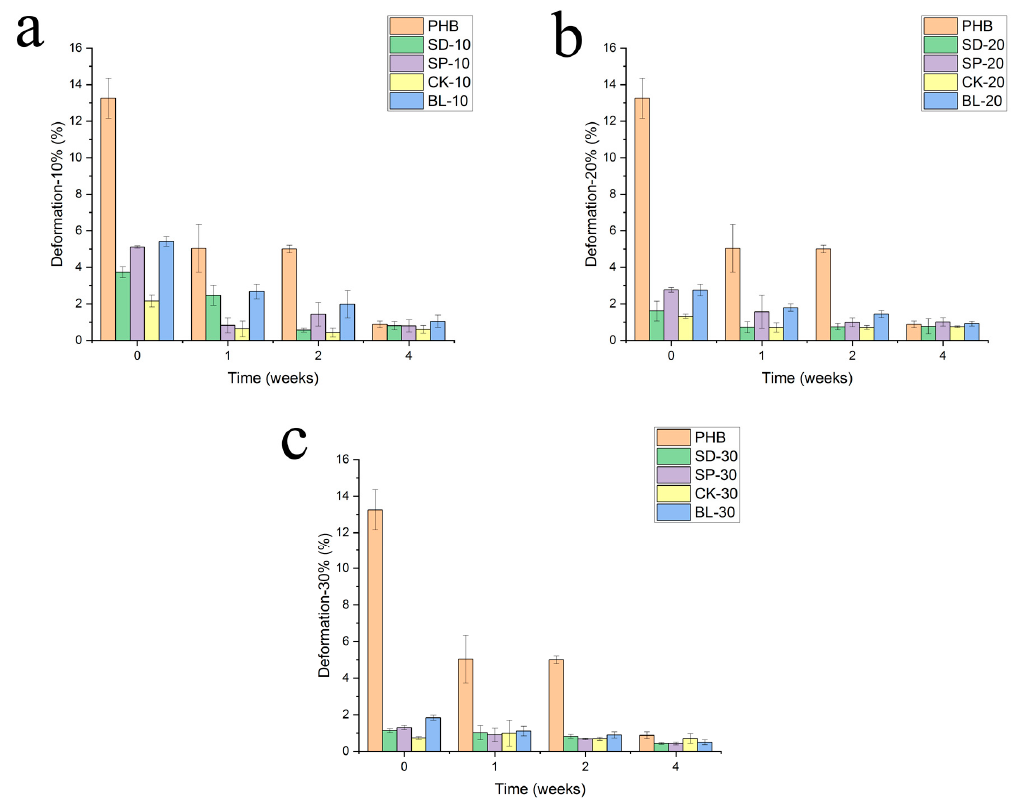
Figure 10. Evolution of the deformation at the break of composites with the exposure time in Xenotest chamber. Reinforcement: ( a ) 10%, ( b ) 20% and ( c ) 30%.